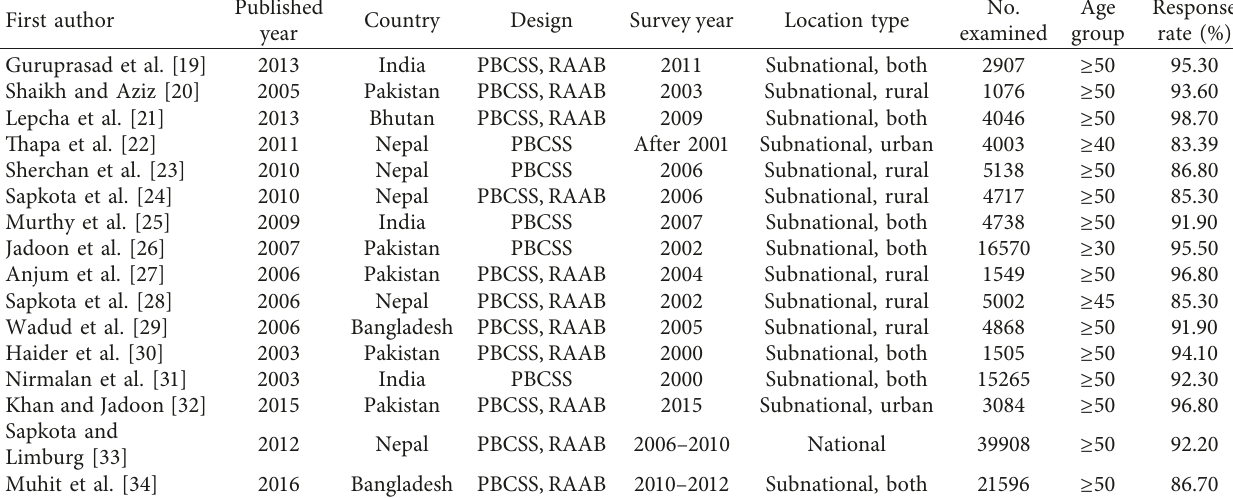
Table 1: Characteristics of studies included in the meta-analysis.